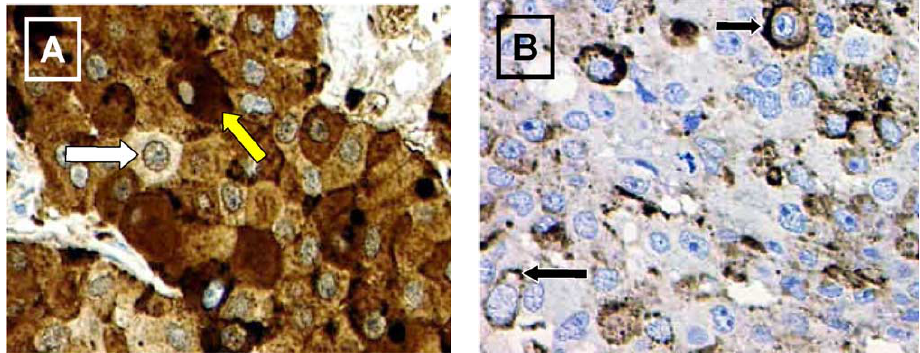
Fig. 1. Immunohistochemical determination of ApoD in breast cancer tissue. (A) Strong cytoplasmic (yellow arrow) and perinuclear membrane area (white arrow) staining. (B) Staining of outer cell membrane (black arrows).